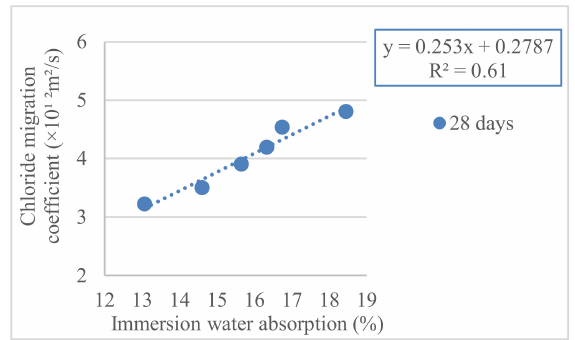
Figure 12. Relationship between chloride migration and immersion water absorption results at 28